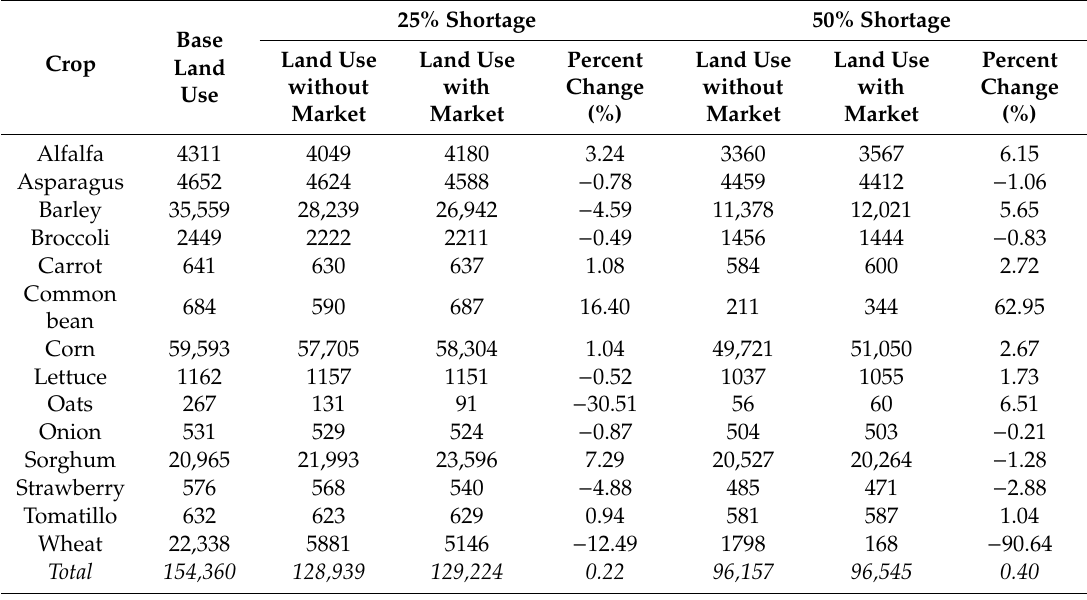
Table 5. Irrigated crop area (in hectares) with and without drought and water